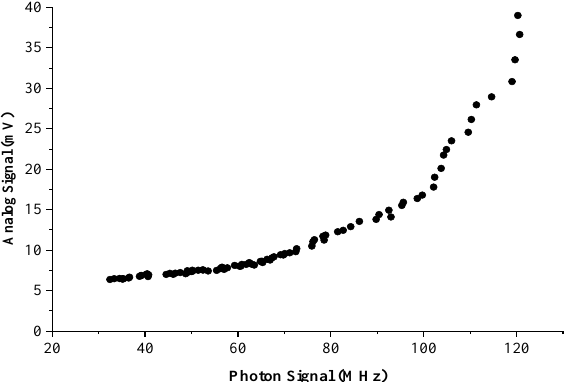
Figure 8. Line relationship diagram of AD and PC signals in the splicing area.